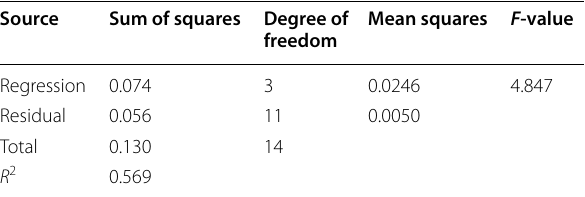
Table 4 ANOVA result for